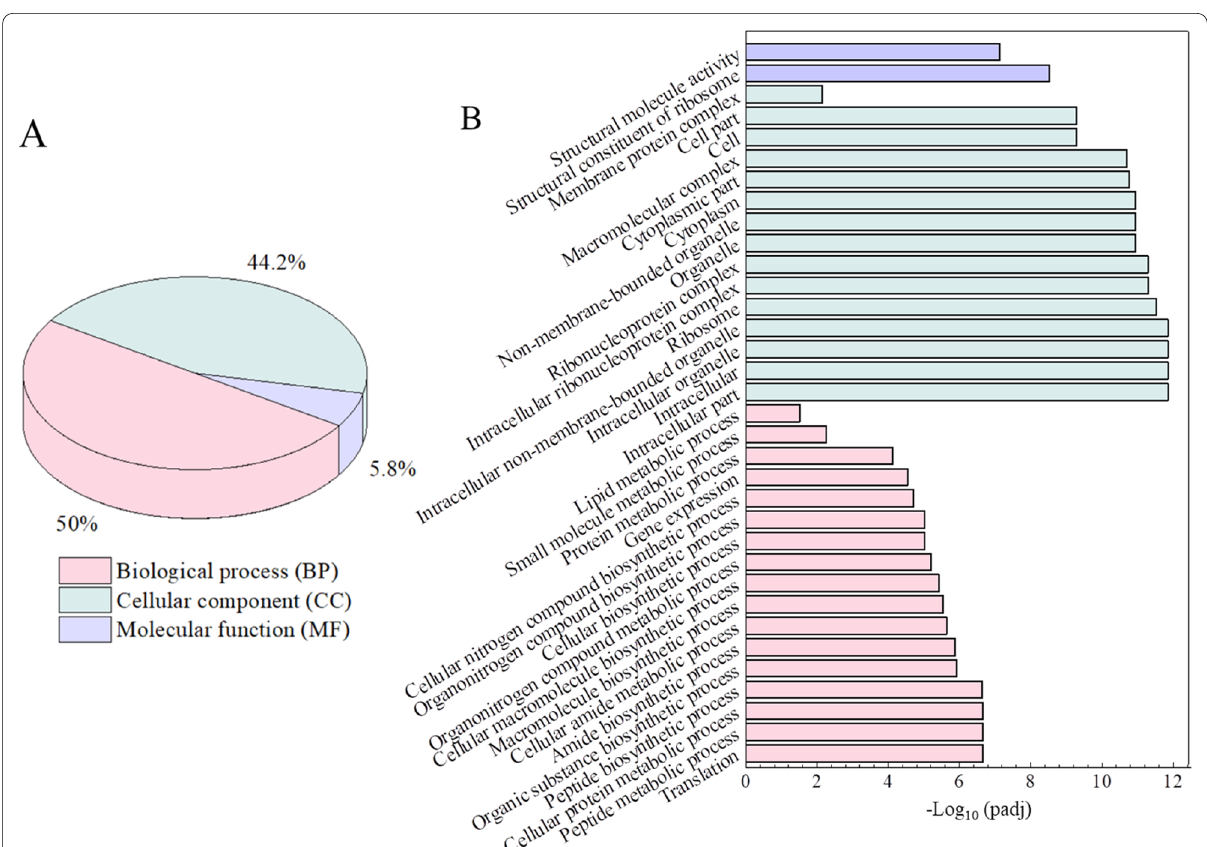
Fig. 8 Gene ontology analysis of DEGs of E. coli W3110 under gallic acid stress versus fermentation without stress. A Proportion of BP, CC, MF. B Gene function classification and padj